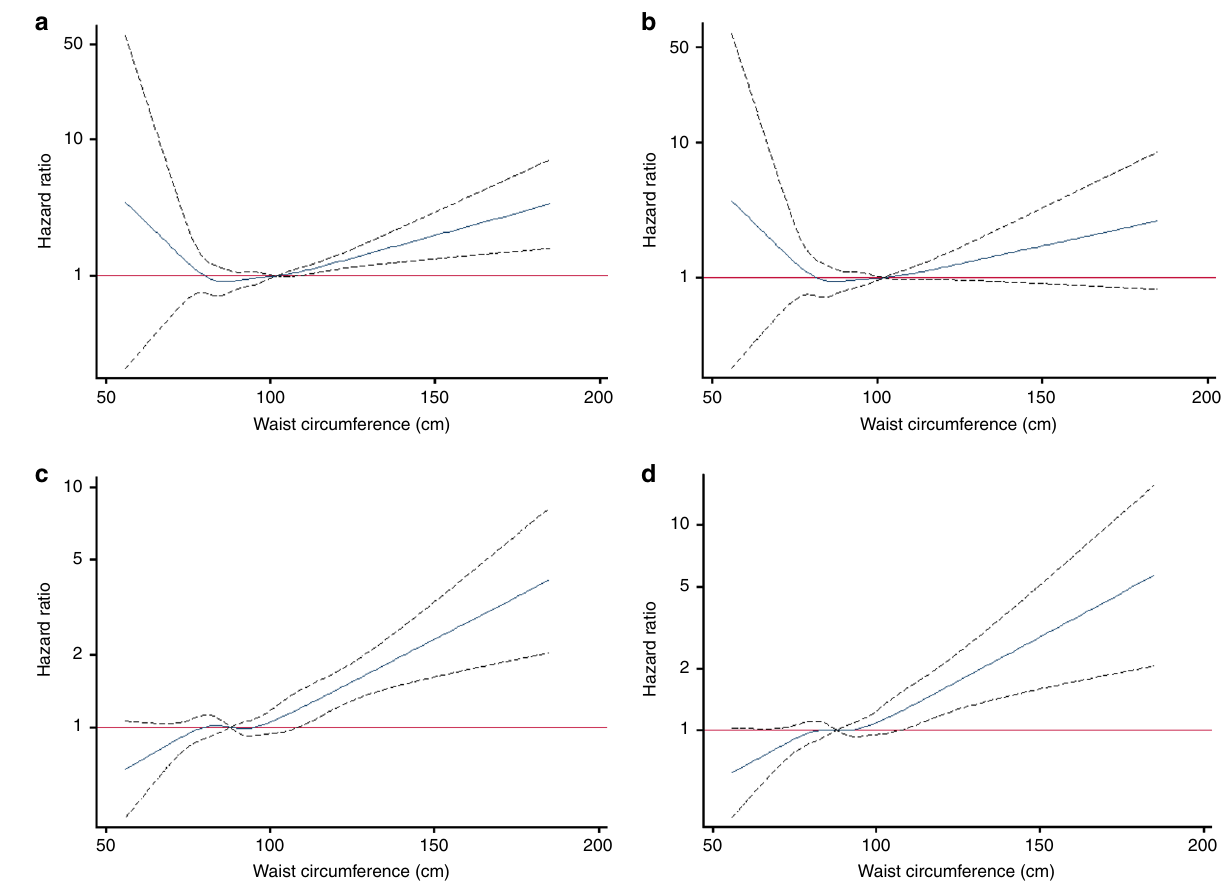
Fig. 2 a Effect of waist circumference on all-cancer risk among males (987 cancer cases) in the Alberta ’ s Tomorrow Project ( N = 9780) adjusted for covariates. b Effect of waist circumference on all-cancer risk among males (986 cancer cases) in the Alberta ’ s Tomorrow Project ( N = 9763) adjusted for covariates and continuous BMI. c Effect of waist circumference on all-cancer risk among females (1291 cancer cases) in the Alberta ’ s Tomorrow Project ( N = 15,935) adjusted for covariates. d Effect of waist circumference on all-cancer risk among females (1289 cancer cases) in the Alberta ’ s Tomorrow Project ( N = 15,911) adjusted for covariates and continuous BMI. All models were adjusted for age (continuous), ethnicity (white/other), marital status (married or living with someone/divorced, separated, or widowed/single, never married), highest level of education (high school or less/some post-high school education/post-high school certi fi cate or degree), total household income ($0 – $49,999/$50,000 to $99,999/ ≥ $100,000), geographical area of residence (urban/rural), smoking status (current/former/never), alcohol consumption (grams of ethanol per day), energy intake (kilocalories per day), total physical activity (MET-hours per week), history of diabetes (yes/no) and family history of cancer (yes/no). This fi gure contains the hazard ratio represented by the blue line and the 95% con fi dence intervals represented by the dashed black lines on either side of the blue line. The red line represents the null value of 1 for the hazard